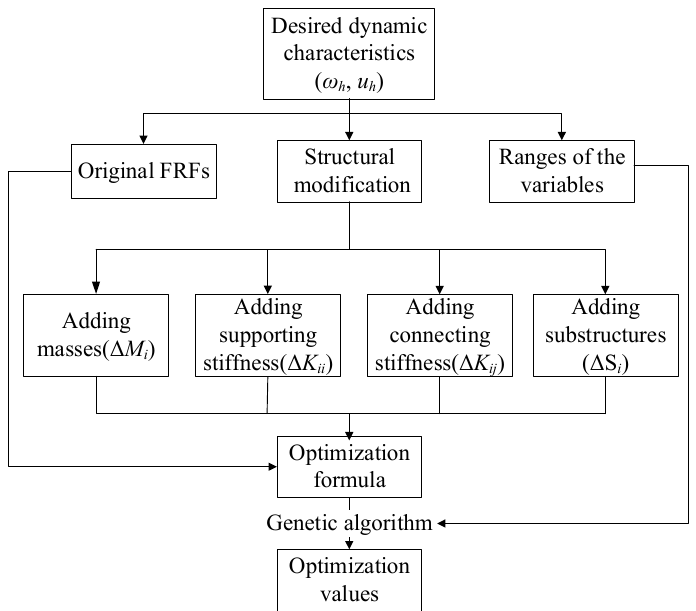
Figure 7. Complete schematic flow chart of assignment of natural frequencies and modes.